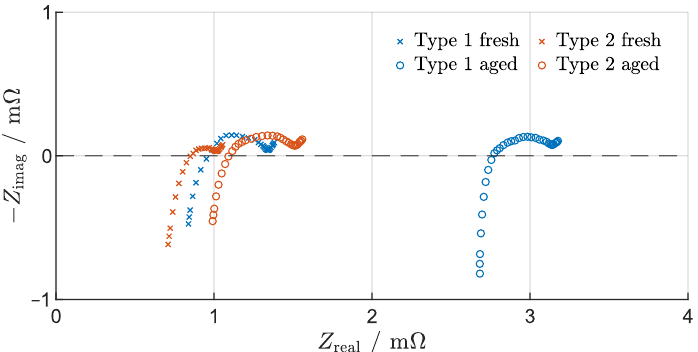
Figure 3. Impedance spectra for fresh and aged cells of type 1 and 2 at 90% and 80% SOH,